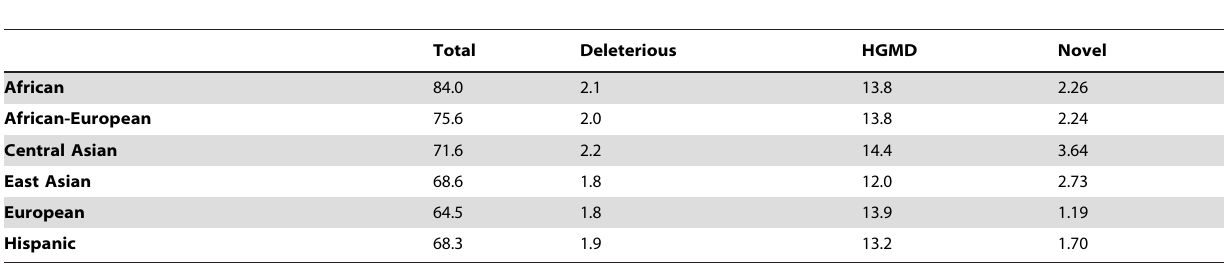
Table 2. Average numbers of cancer-gene variants per individual by ancestry.